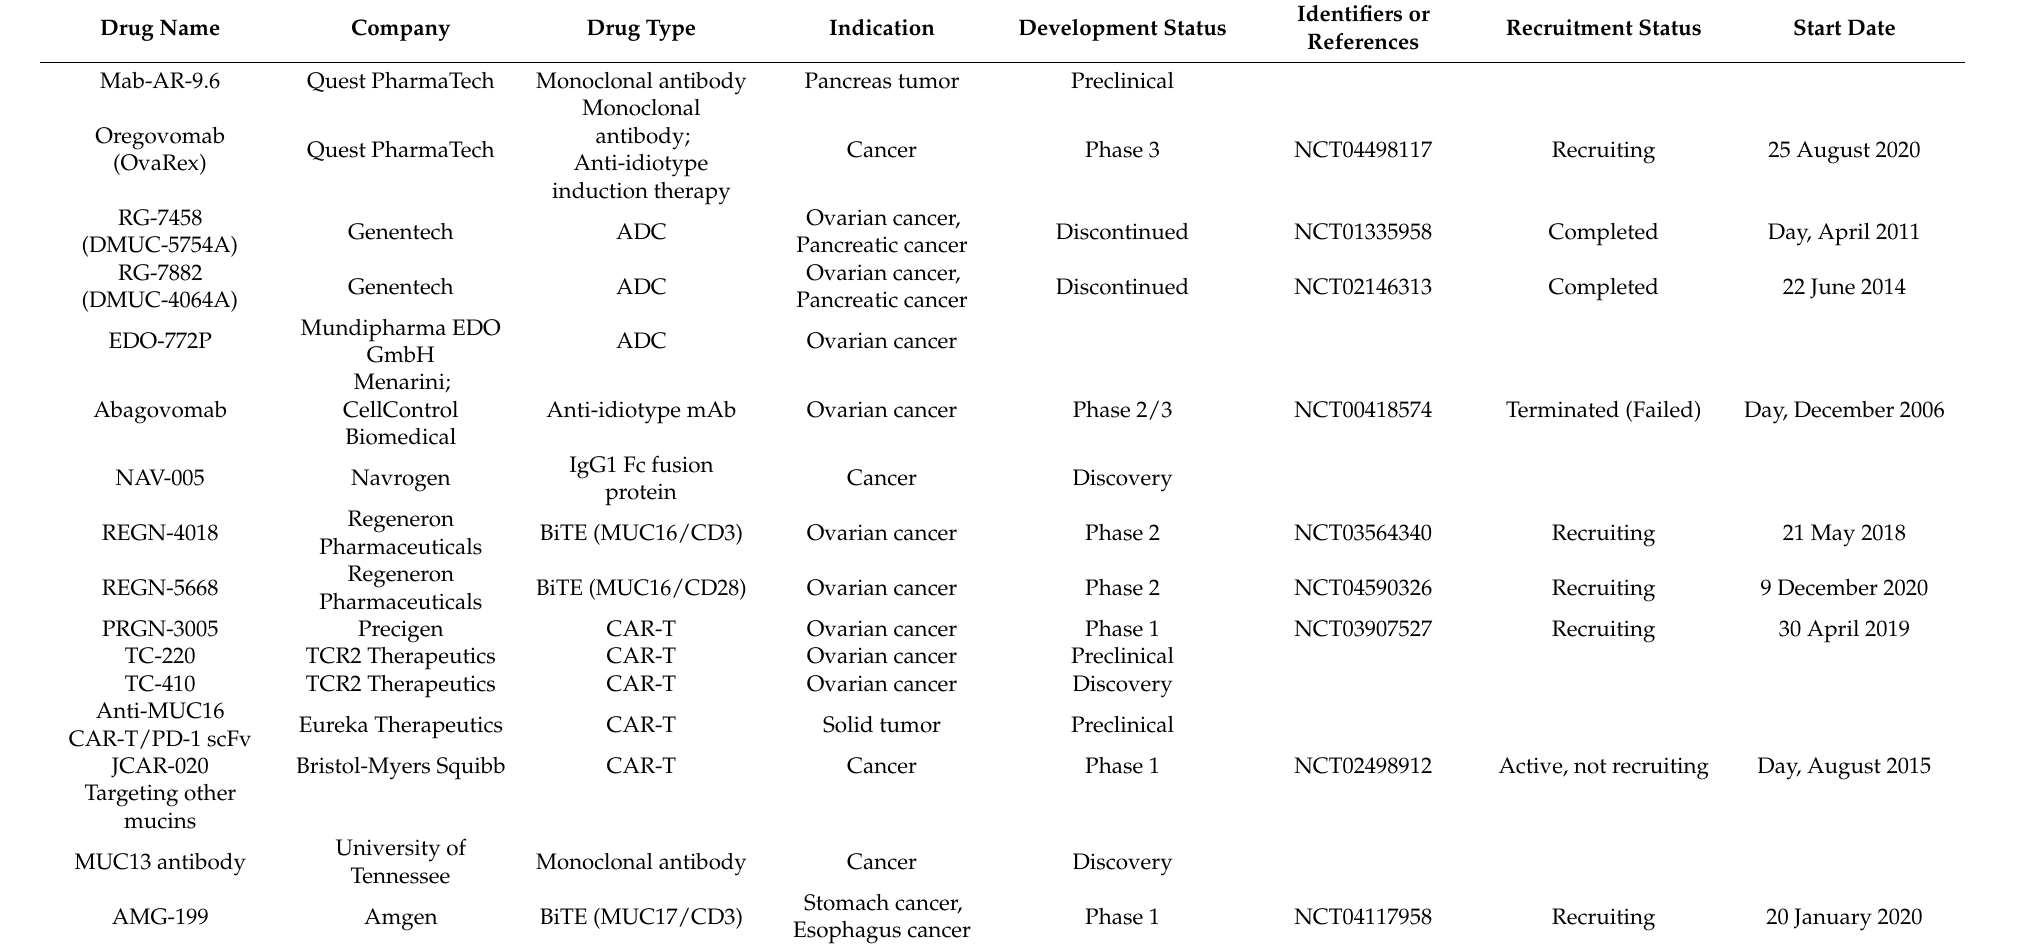
Table 2. Current therapeutic candidates that target MUC16 and other membrane-bound mucin